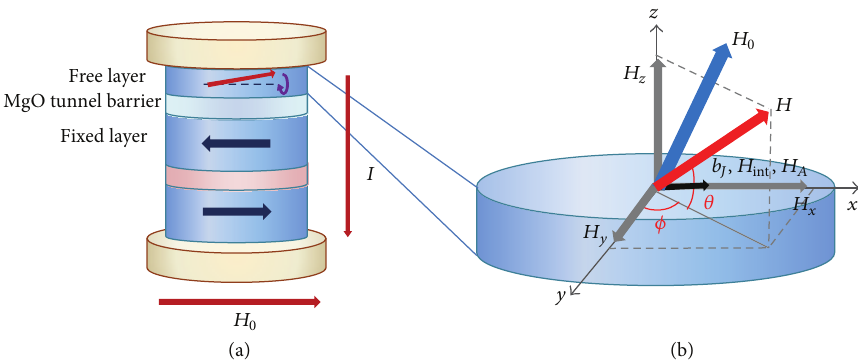
Figure 1: Simple schematic diagrams of (a) MTJ-STO device, (b) three axis components of the external and internal magnetic fields. The perpendicular torque 𝑏 𝐽 acts like a magnetic field and is added to the direction of the fixed layer